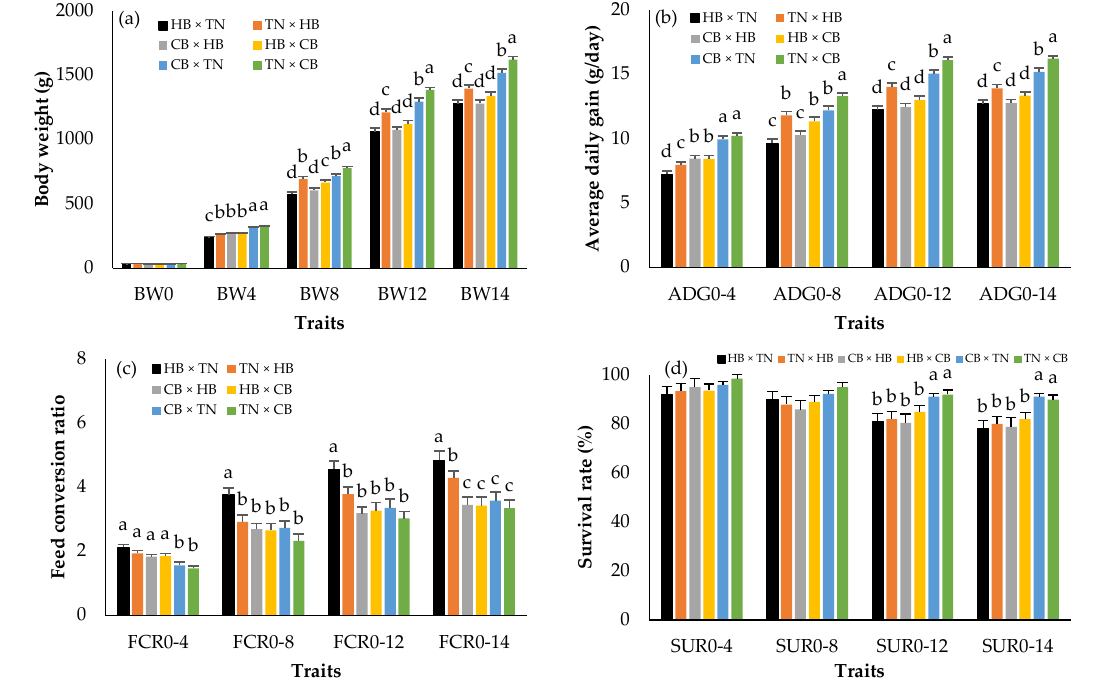
Figure 2. Least squares means (standard error) of body weight ( a ); average daily gain ( b ); feed conversion ratio ( c ); survival rate ( d ) in purebred black-bone and Thai native chickens; a, b, c, d: Means for the trait with different letters differ significantly at p < 0.05; HB × TN — crossbred chicken between Hmong black-bone chicken (used as chicken cocks) and Thai native chicken (used as chicken hens) (black bar); TN × HB — crossbred chicken between Thai native chicken (used as chicken cocks) and Hmong black-bone chicken (used as chicken hens) (orange bar); CB × HB — crossbred chicken between Chinese black-bone chicken (used as chicken cocks) and Hmong black-bone chicken (used as chicken hens) (gray bar); HB × CB — crossbred chicken between Hmong black-bone chicken (used as chicken cocks) and Chinese black-bone chicken (used as chicken hens) (yellow bar); CB × TN — crossbred chicken between Chinese black-bone chicken (used as chicken cocks) and Thai native chicken (used as chicken hens) (blue bar); TN × CB—crossbred chicken between Thai native chicken (used as